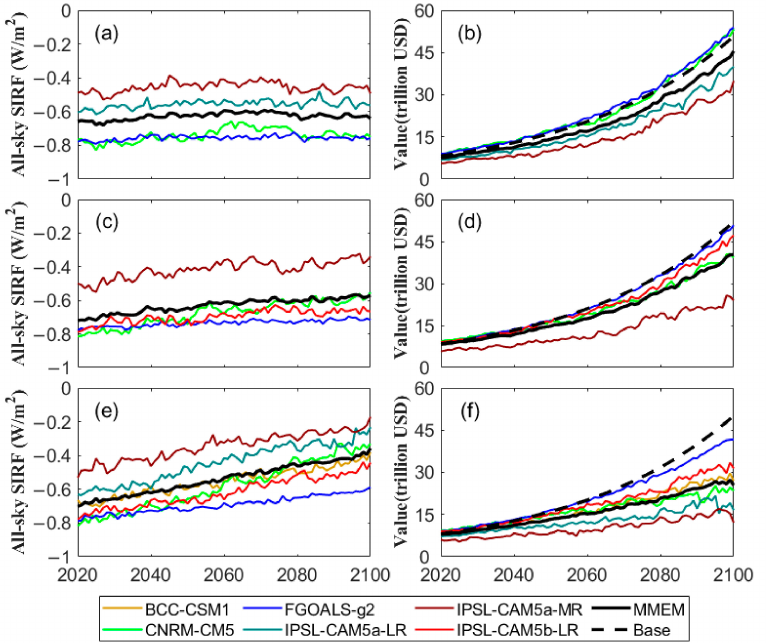
Figure 7. Time series of Arctic SIRF and its economic value during 2020–2100 ( a , b ) RCP2.6. ( c , d ) RCP4.5. ( e , f )